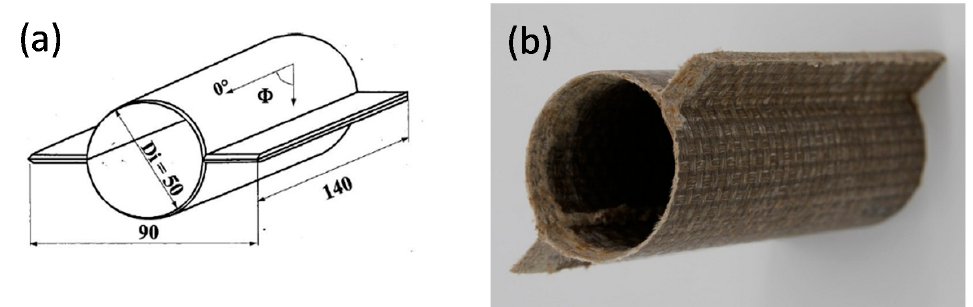
Figure 2. Specimen dimensions in mm for crash-tubes. ( a ) sketch of the specimen geometry; ( b ) specimen picture.